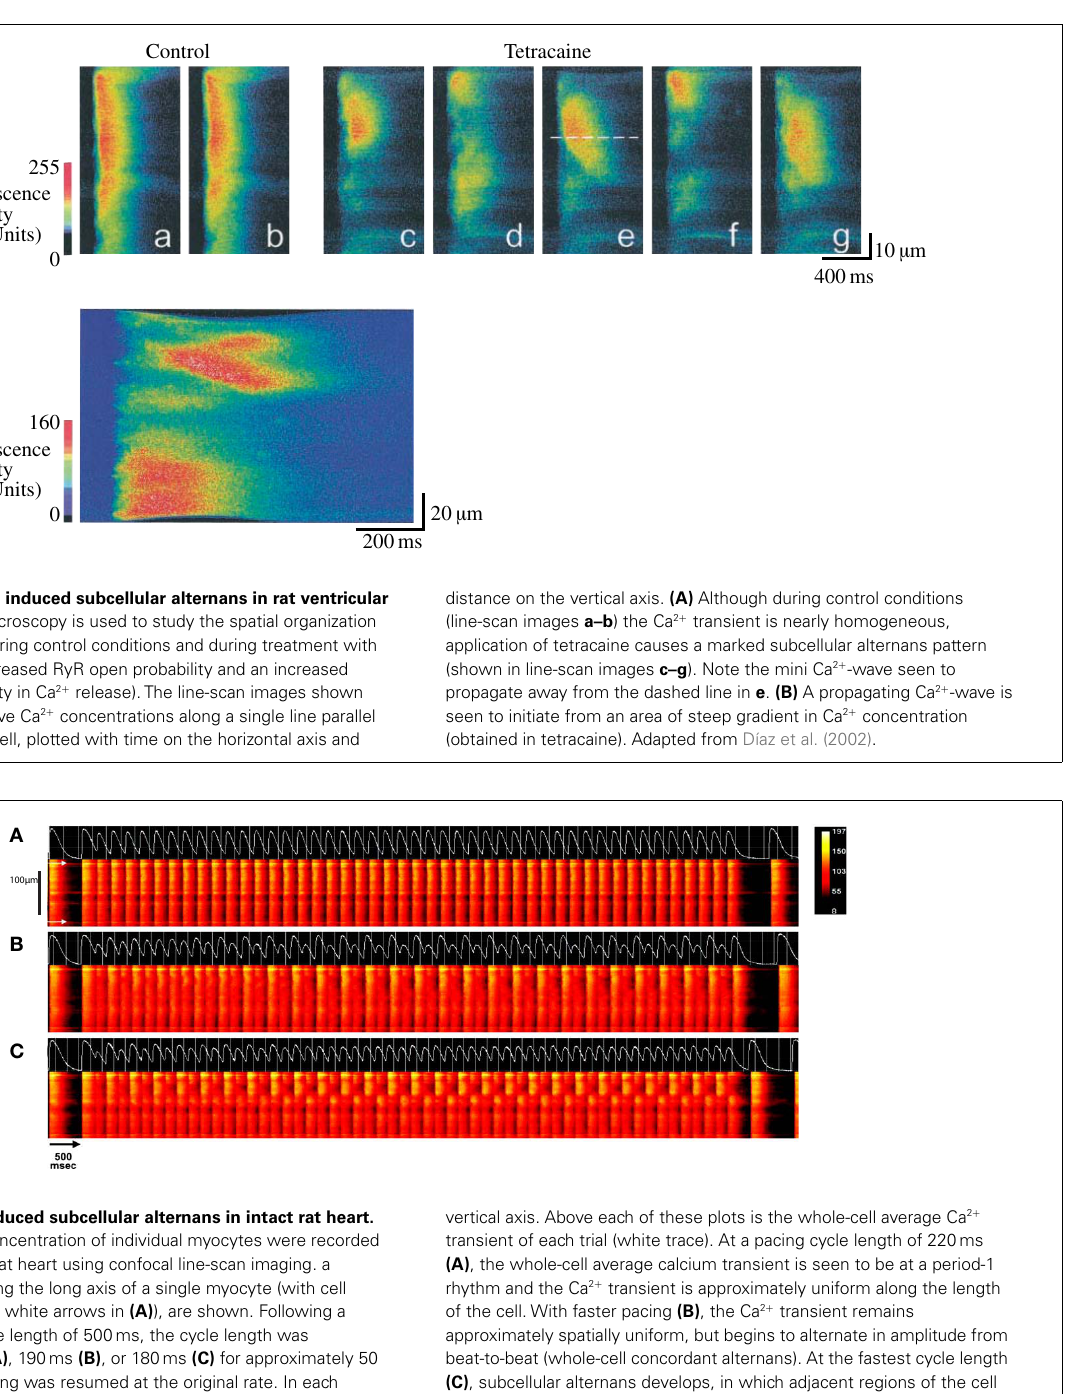
vertical axis. Above each of these plots is the whole-cell average Ca 2 + transient of each trial (white trace). At a pacing cycle length of 220ms (A) , the whole-cell average calcium transient is seen to be at a period-1 rhythm and the Ca 2 + transient is approximately uniform along the length of the cell.With faster pacing (B) , the Ca 2 + transient remains approximately spatially uniform, but begins to alternate in amplitude from beat-to-beat (whole-cell concordant alternans). At the fastest cycle length (C) , subcellular alternans develops, in which adjacent regions of the cell (the top and bottom half, roughly) alternate out-of-phase, but the whole-cell average Ca 2 + transient is at a nearly period-1 rhythm. Adapted from Aistrup et al.